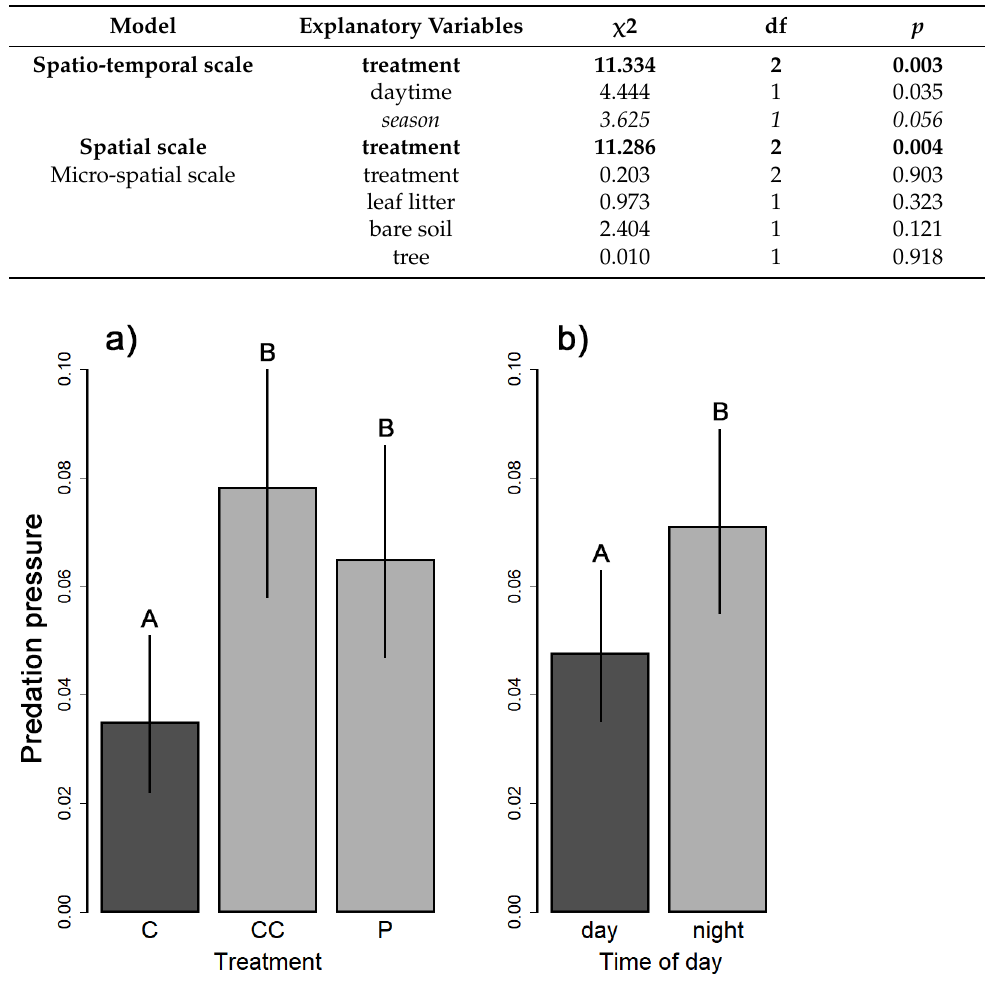
Figure 2. The effect of treatment ( a ) and time of day ( b ) on the predation pressure. Vertical lines represent a 95% confidence interval and different capital letters above the bars indicate significant differences based on Tukey multiple comparisons of means.